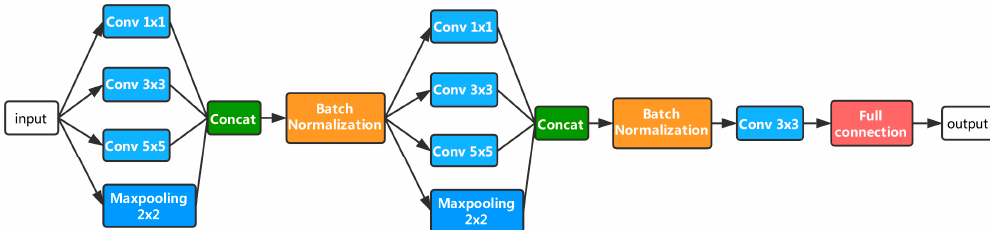
Figure 3. Convolutional neural network (CNN) architecture used in this study.